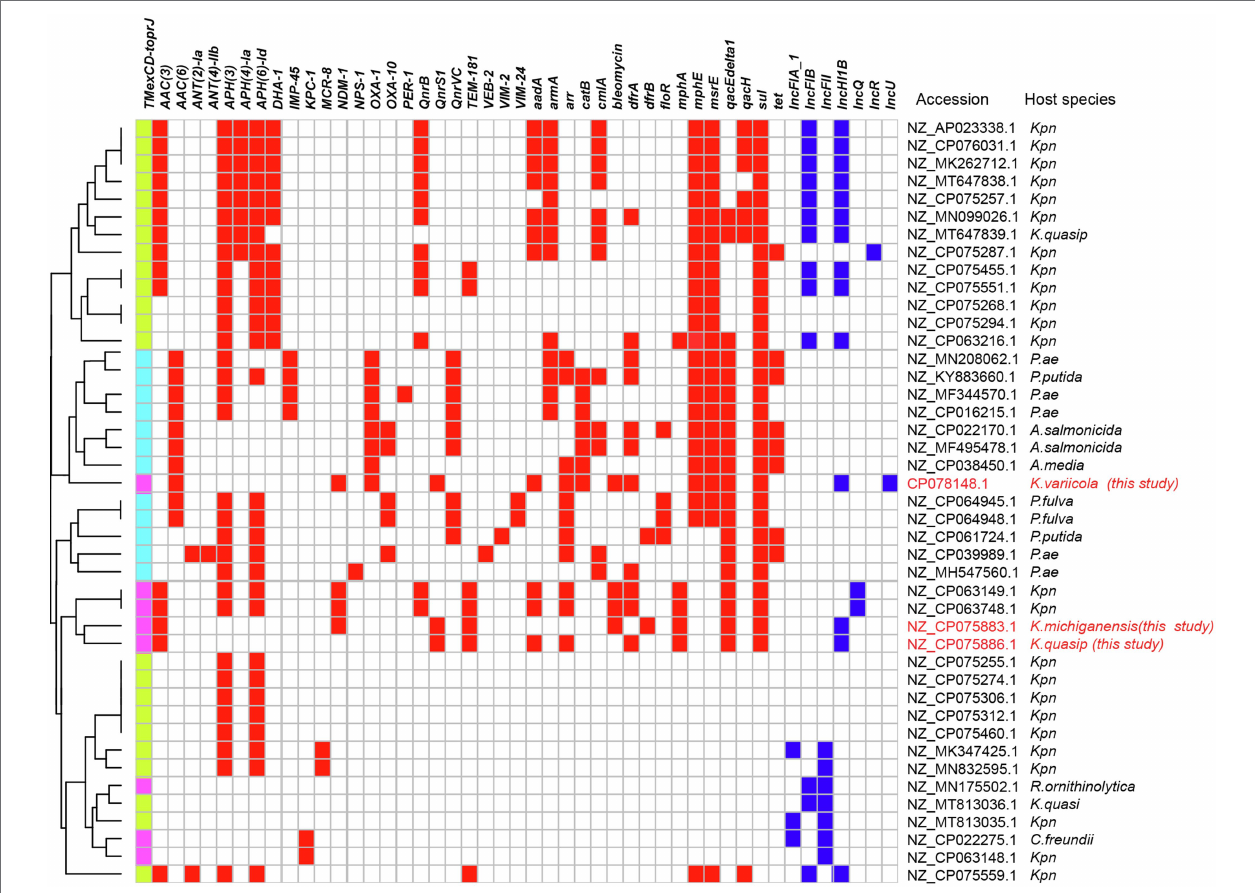
FIGURE 4 | TMexCD-toprJ -harboring plasmids. The heatmap shows the distribution of plasmid replicons (dark blue boxes) and antibiotic resistance genes (red boxes) detected within 51 TMexCD-toprJ -harboring plasmids. The variants of TMexCD-toprJ resistance genes are indicated in green ( TMexCD1-toprJ1 ), pink ( TMexCD2-toprJ2 ), and light blue ( TMexCD3-toprJ3 ) boxes. GenBank accession numbers and species are listed on the right-hand side. Kpn , Klebsiella pneumoniae ; K. quasip , Klebsiella quasipneumoniae ; Pae , Pseudomonas aeruginosa ; P. putida , Pseudomonas putida ; A. salmonicida , Aeromonas salmonicida